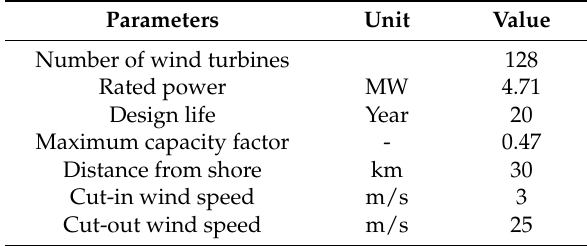
Table 2. Basic technical parameters.